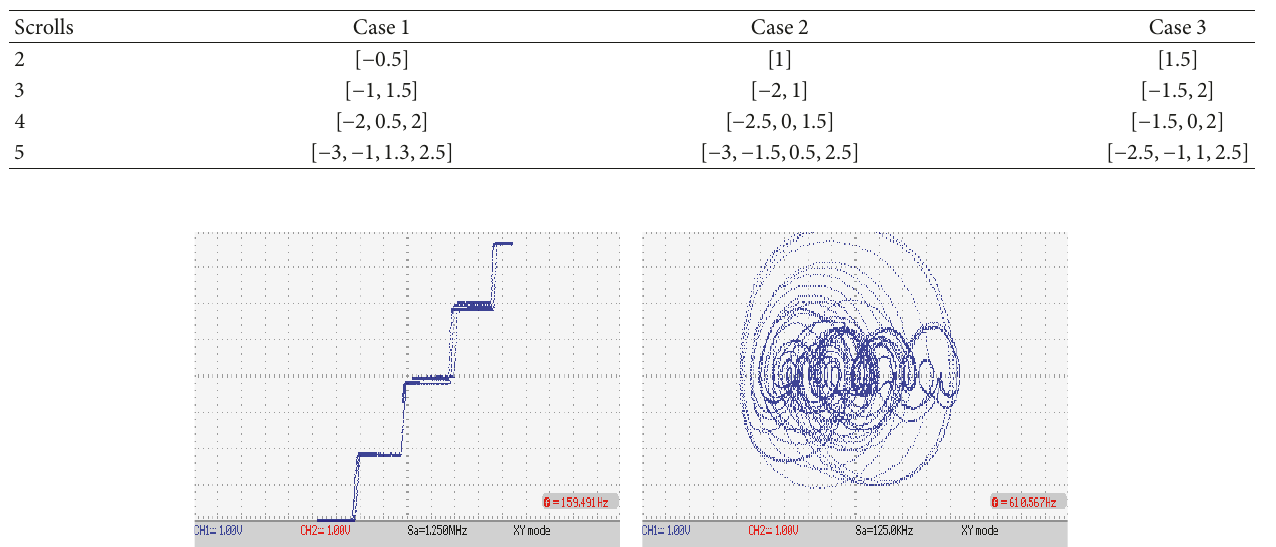
Table 5: Proposed values for modifying the delay ℎ .